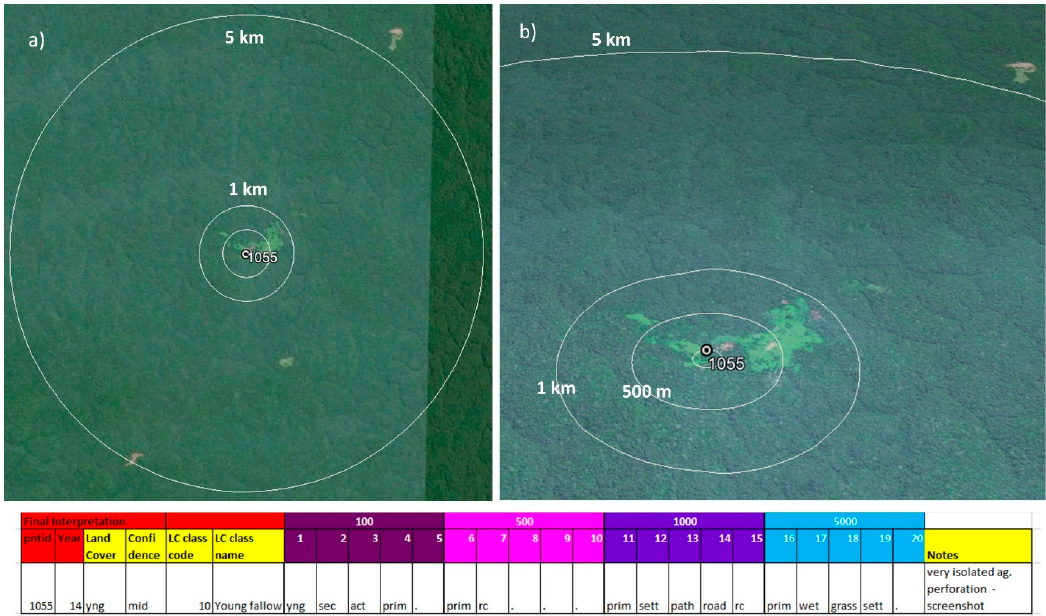
Figure 5. ( a , b ) (oblique view) Example of the photo-interpretation of a sample point and its bu ff ers: In this example (point 1055), the imagery is from 2014, the centroid is marked as “young fallow” and the first slot of the interpreted land cover in each bu ff er shows the dominance of young fallow in the 100 m bu ff er and primary forest in the 500 m, 1 km, and 5 km bu ff er. The presence of other land cover 23 ◦ 39 (cid:48) 28.05”